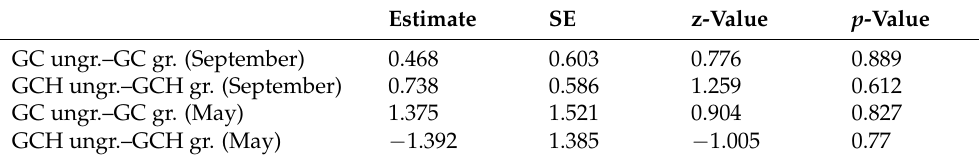
Table A21. Differences in activity densities of open-habitat carabid beetles, comparing the grazed pastures and ungrazed strips of the grass–clover (GC) and the grass–clover herbs (GCH) in May/June and September.